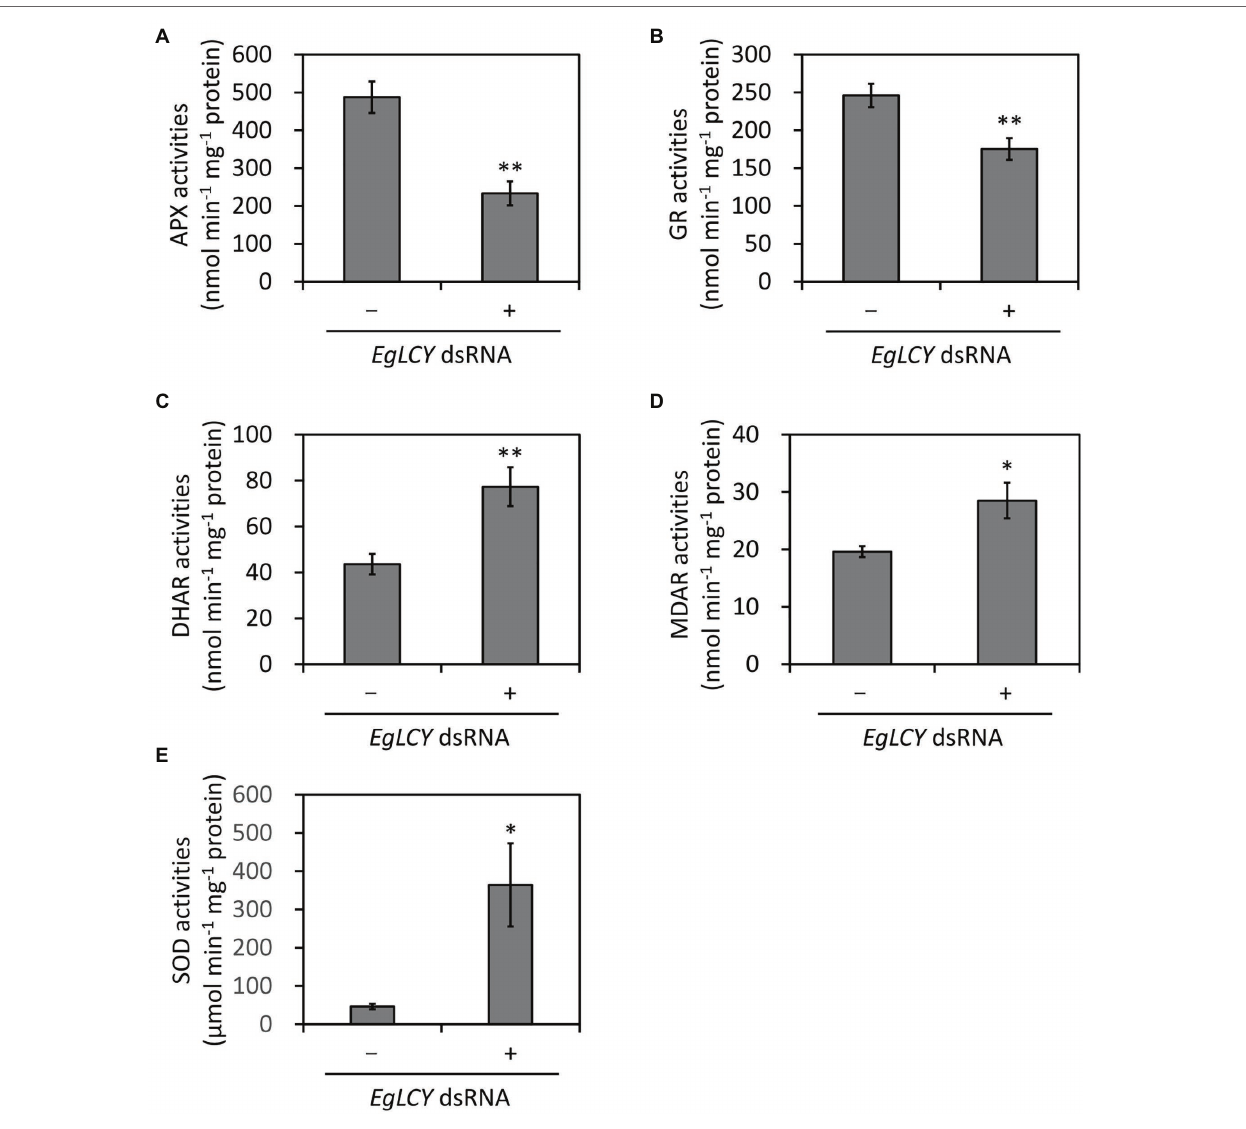
FIGURE 6 | Effects of EgLCY suppression on the activities of the ascorbate-glutathione cycle enzymes. Cells treated with or without EgLCY dsRNA were mixotrophically grown under continuous light (40 μ mol photons m − 2 s − 1 ) at 25 ° C for 6 d. Enzyme activities of ascorbate peroxidase (A) , glutathione reductase (B) , dehydroascorbate reductase (C) , monodehydroascorbate reductase (D) , and superoxide dismutase (E) in extracts from cells treated with or without EgLCY dsRNA. Values are presented as the mean ± SD ( n = 3). Values with asterisks are significantly different from cells treated without dsRNA according to the t -test (* p < 0.05; ** p <